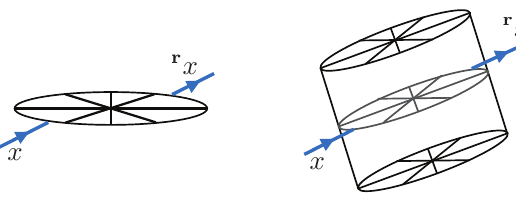
Figure 9: Left: crosscap, interpreted as a reflection symmetry defect, in space. We can consider flattening it and treating it on the same footing as other g -defects for unitary orientation-preserving symmetries. Right: in space-time, the reflection symmetry defect corresponds to a crosscap